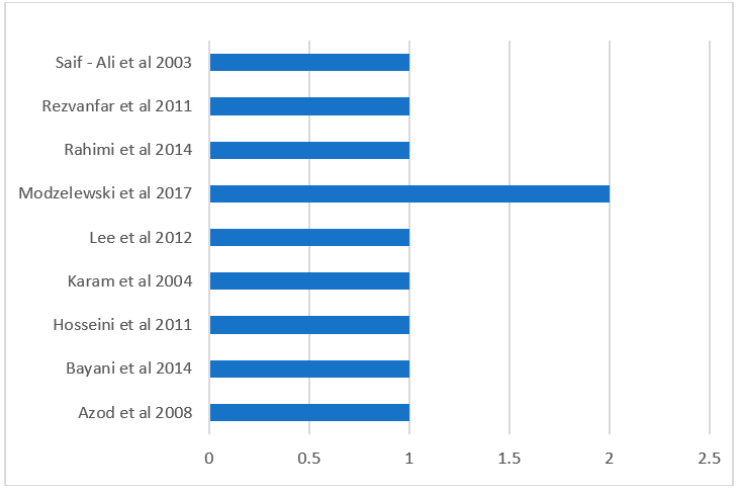
Figure 3. Overall Risk of Bias (1 unit represents a low risk of bias while 2 represent moderate risk of bias).